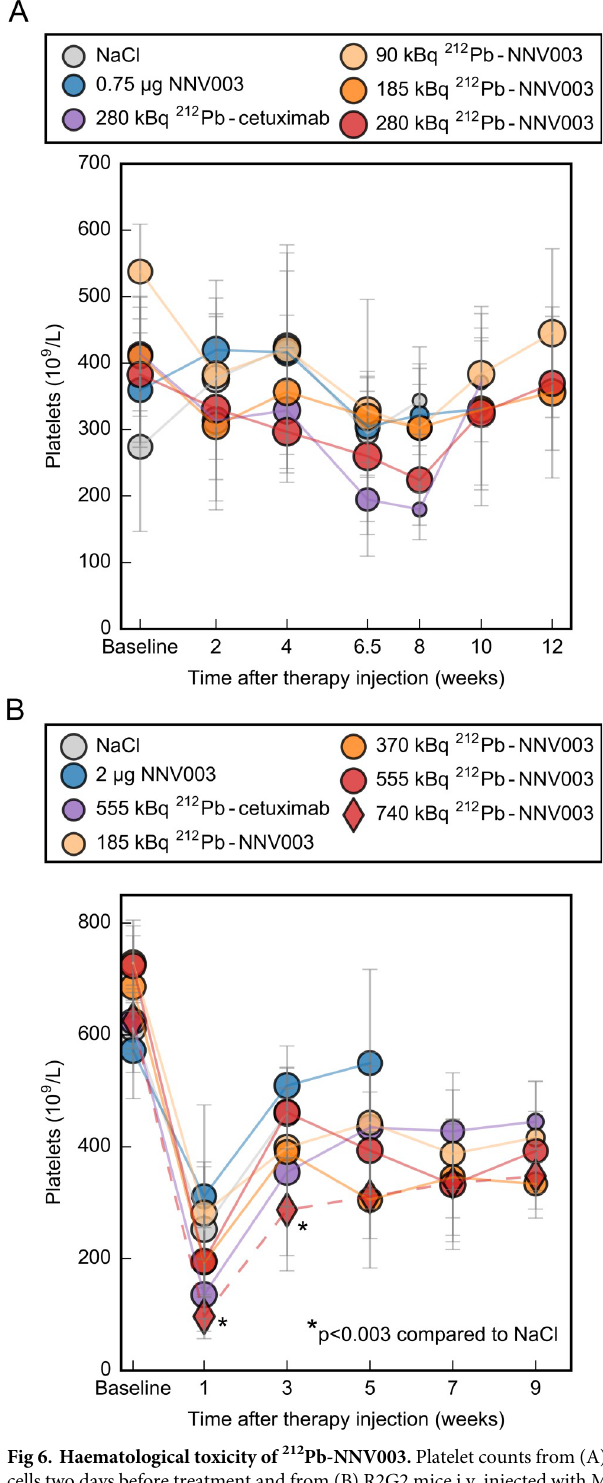
Fig 6. Haematological toxicity of 212 Pb-NNV003. Platelet counts from (A) CB17 SCID mice i.v. injected with Daudi cells two days before treatment and from (B) R2G2 mice i.v. injected with MEC-2 cells two days before treatment. Average with error bars = SD. Marker size represents the number of mice at each measurement, ranging from (A) 3–11 and (B) 4–10.